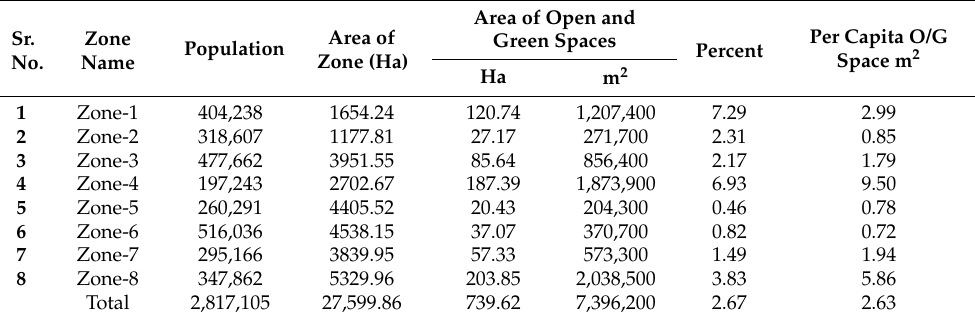
Table 7. Zonewise Existing Situation of Open and Green Spaces in Lucknow City. Sr.